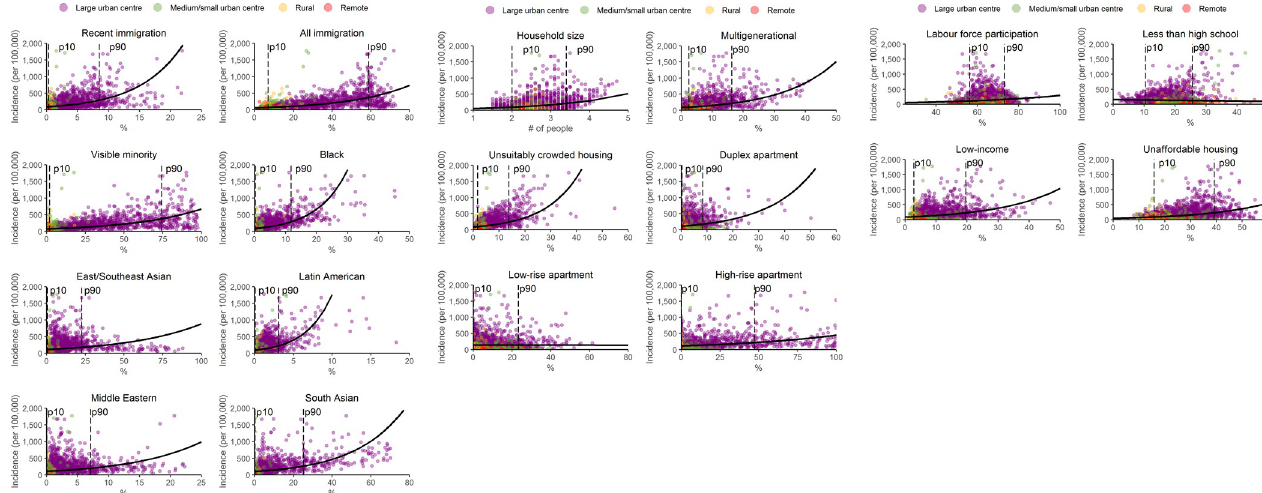
Fig 2. a. Neighbourhood-level incidence of COVID-19 by proportion of immigrant and race, with regression estimates and 10th (p10) and 90th (p90) percentiles. b. Neighbourhood-level incidence of COVID-19 by proportion of housing characteristics, with regression estimates and 10th (p10) and 90th (p90) percentiles. c. Neighbourhood-level incidence of COVID-19 by proportion of socio-economic status characteristics, with regression estimates and 10th (p10) and 90th (p90)